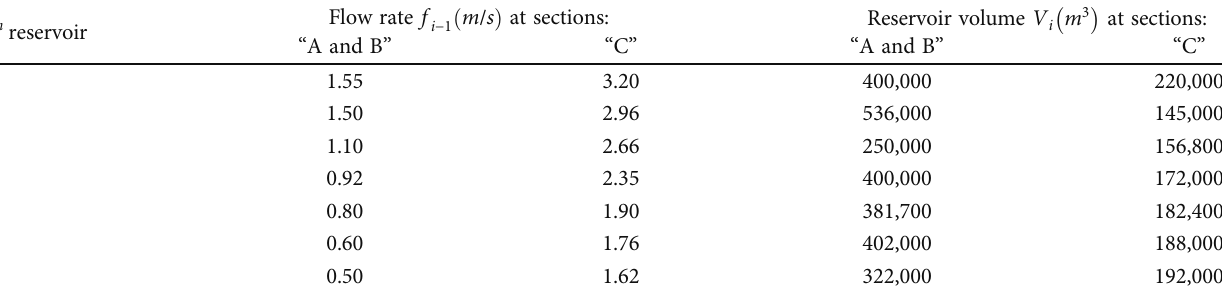
Table 2: Kinematic parameters from River Nyakomisaro.